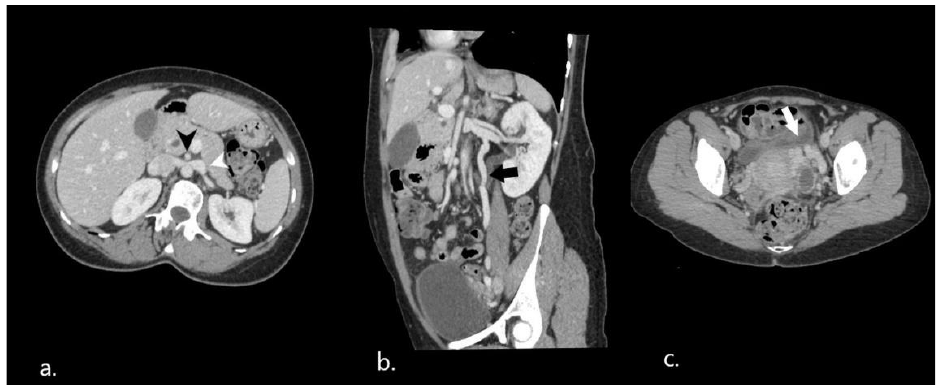
Figure 2. Nutcracker phenomenon on initial CT scan. ( a ) On axial images, the hilar portion of the left renal vein (white arrowhead) is distended as a result of the vein compression between the aorta and the superior mesenteric artery (black arrowhead) ( b ). Coronal reformatted image showing engorged left gonadal vein (black arrow). ( c ) Accompanying pelvic varices.